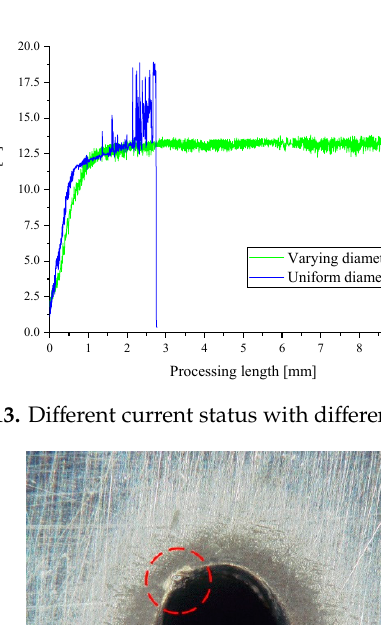
Figure 12. Photographs of WECM.